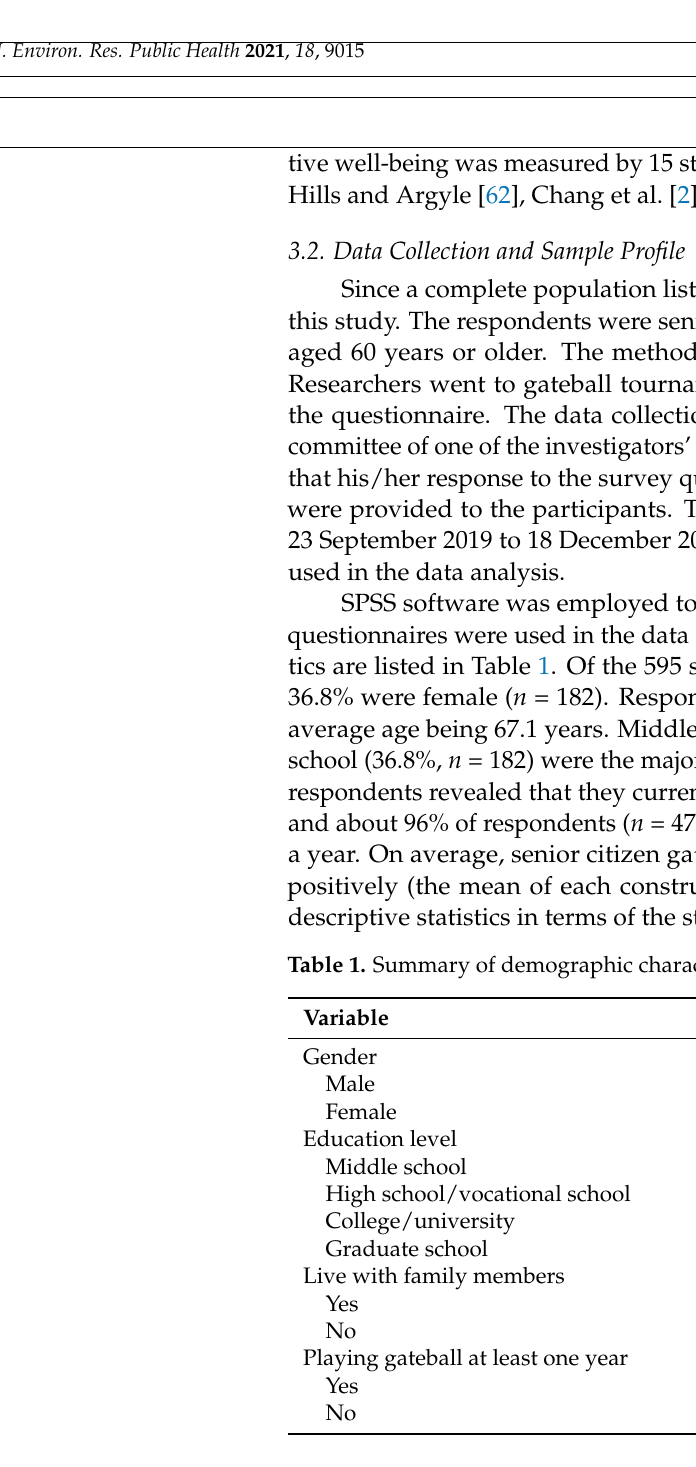
Table 2. Descriptive statistics ( n =